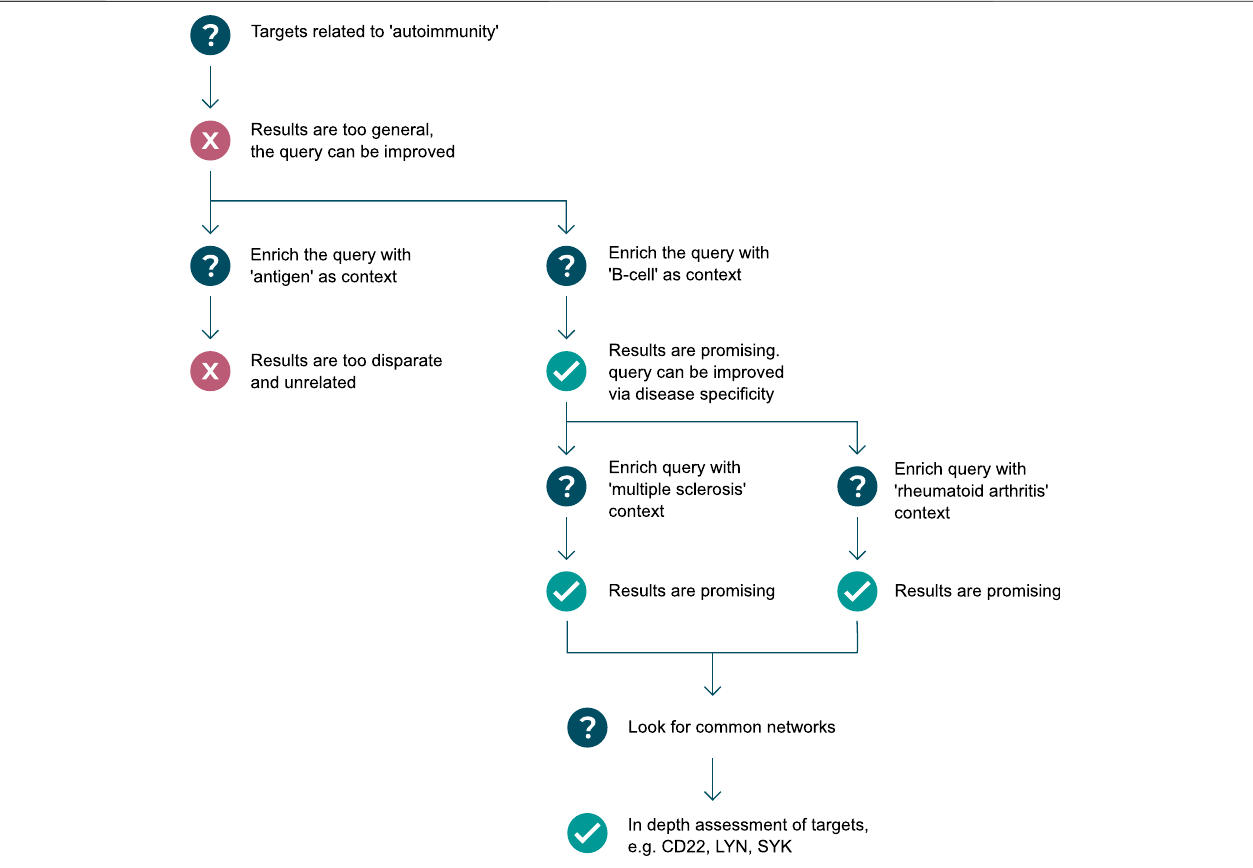
FIGURE 1 | Example use-case of graph pattern querying: in search of targets regulating autoantibody production. Question mark symbols represent stages of askingquestionsoftheknowledgegraph,whichcanresultinundesirableresultsorafailedattemptatqueryingtheknowledgegraph(representedbyredcrosssymbols), or desirable results and successful attempts at querying the knowledge graph (represented by green check mark symbols). A diverging path represents the user exploringpossibilitiesdown both routes, eitherasaresultofafailed attempt,or asaresultoftherebeingtwoequallyvaluableoptionstopursue. Aconverging path represents the user linking the results of two patterns together, in a new pattern.